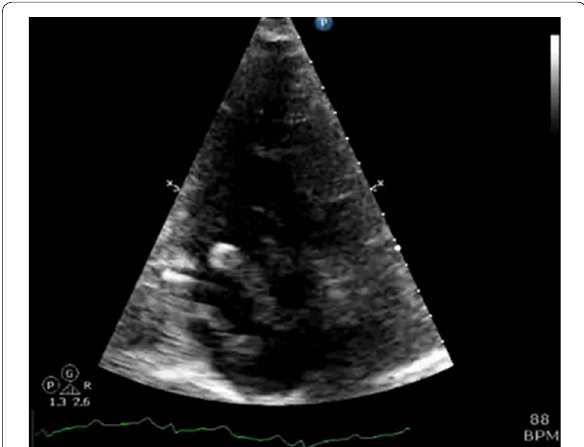
Fig. 3 Apical 4-chamber view with a large mobile thrombus in the right atrium crossing into the right ventricle. There is flattening of the interventricular septum consistent with right ventricular pressure overload. Mc Connell’s sign is present